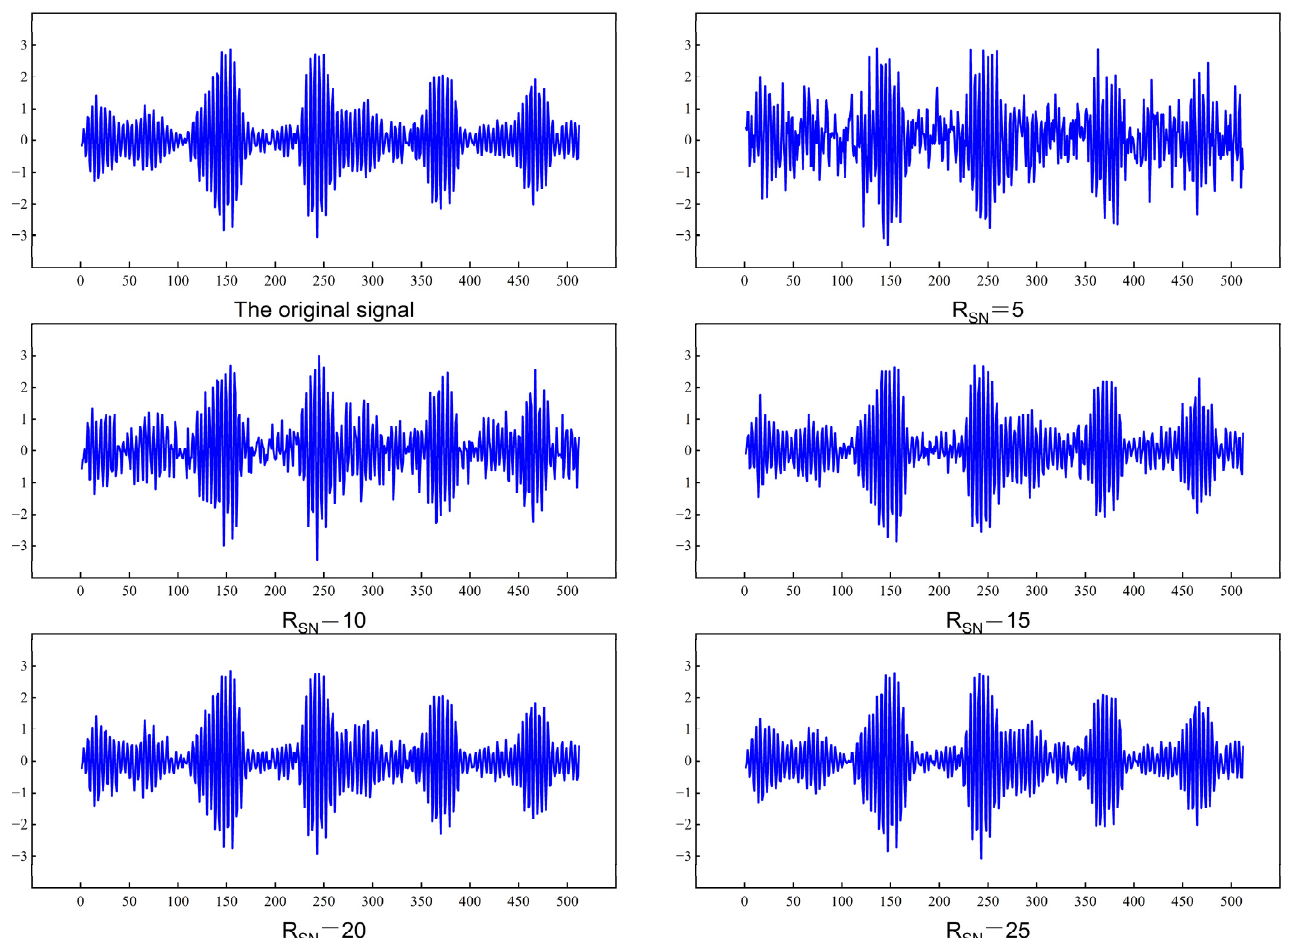
Figure 7. Reconstructed mean square error of AOA-CS algorithm in the presence of noise.